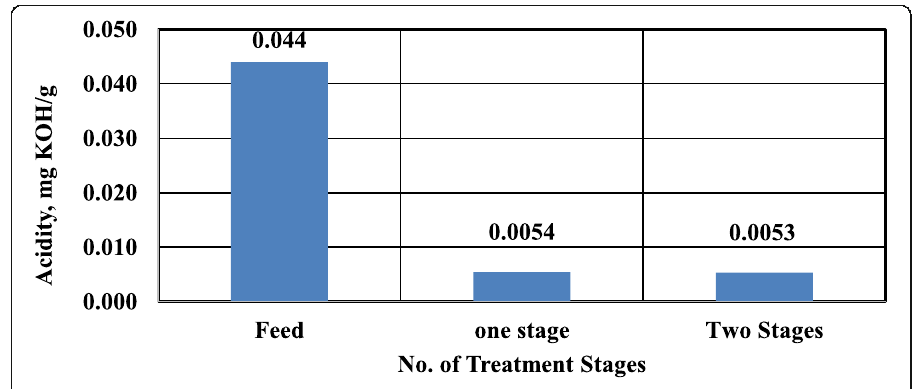
Fig. 4 Effect of number of treatment stages on